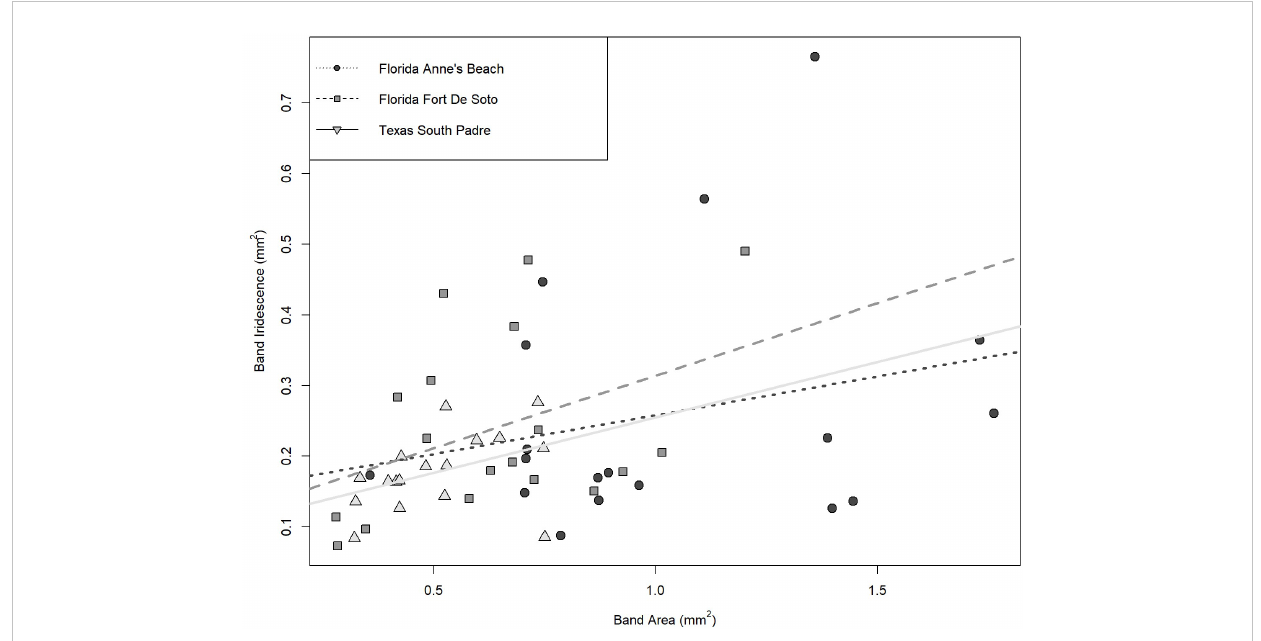
FIGURE 5 The relationship between mean band area and mean band iridescence for the two Florida populations (Anne ’ s Beach and Fort De Soto) and the South Padre, Texas population. The strongest relationships between band area and iridescence were found for South Padre and Fort de Soto, while